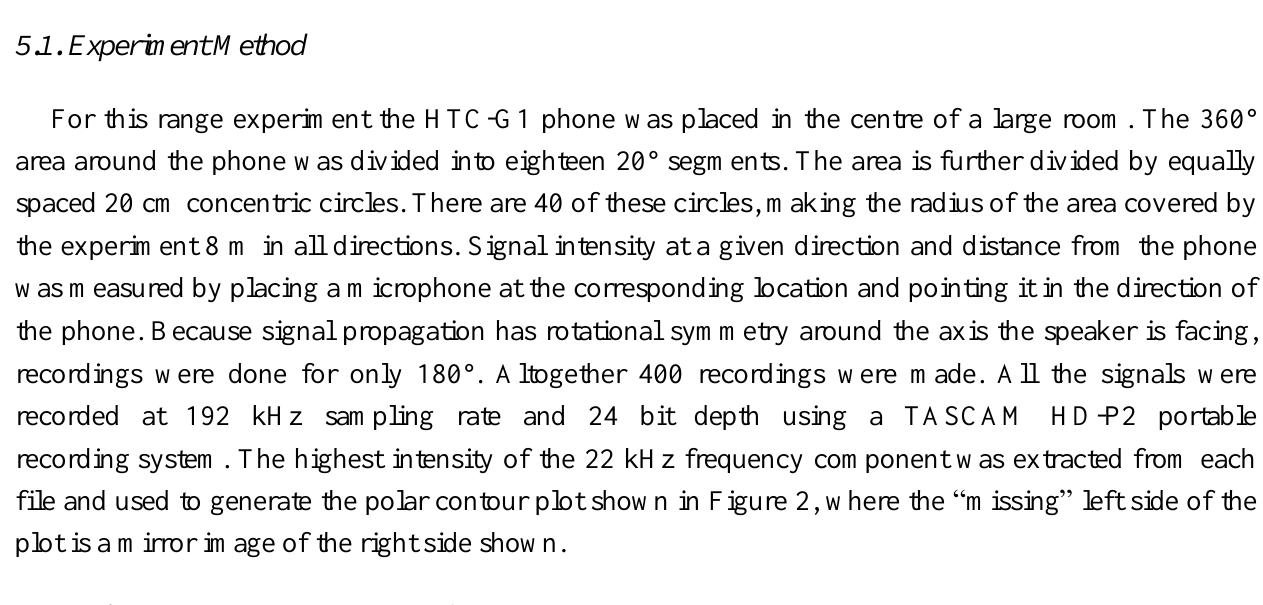
Figure 2. Polar contour plot for ultrasound energy propagation. The semicircle represents the top-down view of 180° area around the phone out to 8 m distance. Chromatic value represents energy intensity level in